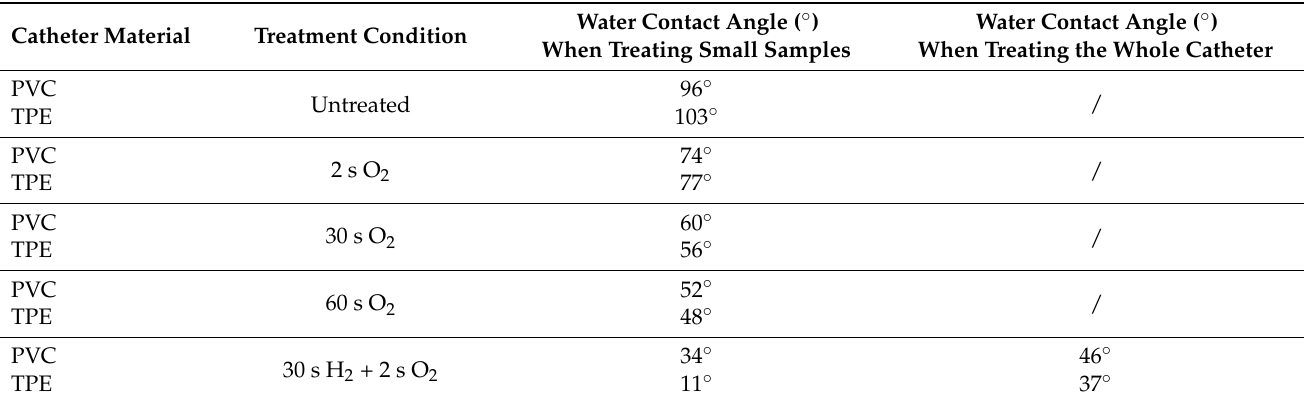
Table 2. Wettability of plasma-treated catheters.